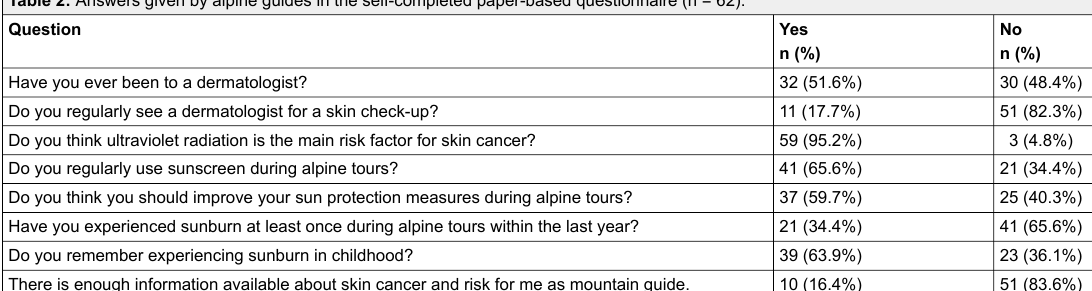
Table 2: Answers given by alpine guides in the self-completed paper-based questionnaire (n = 62).